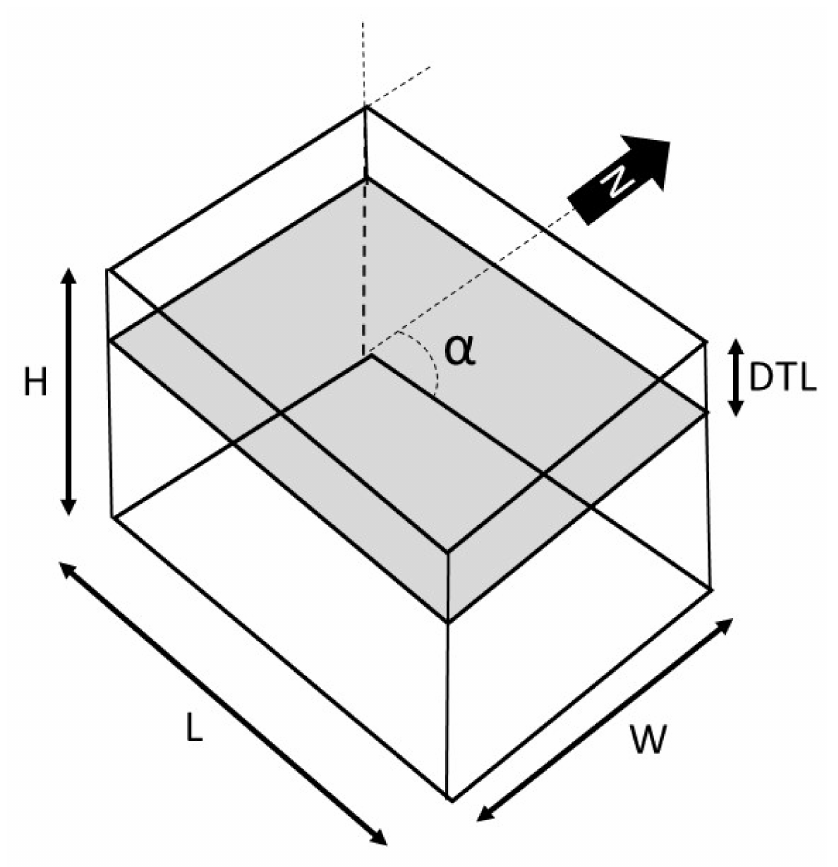
Figure 2. Simple schematization of the rectangular tank. The gray surface represents the emitting